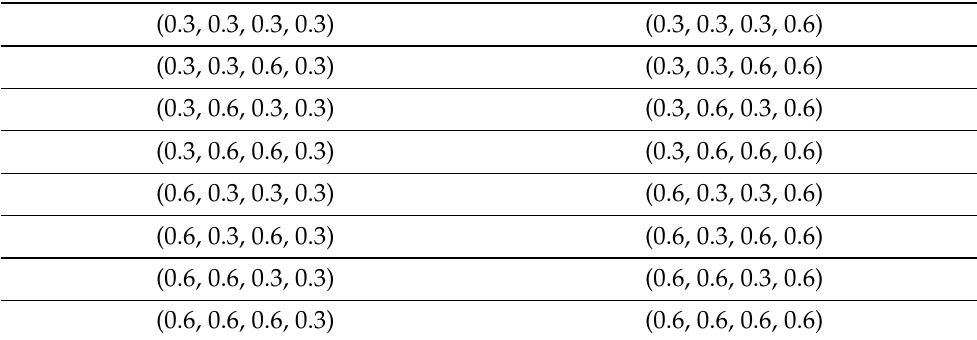
Table 1. 16 INIDs for building interpolation